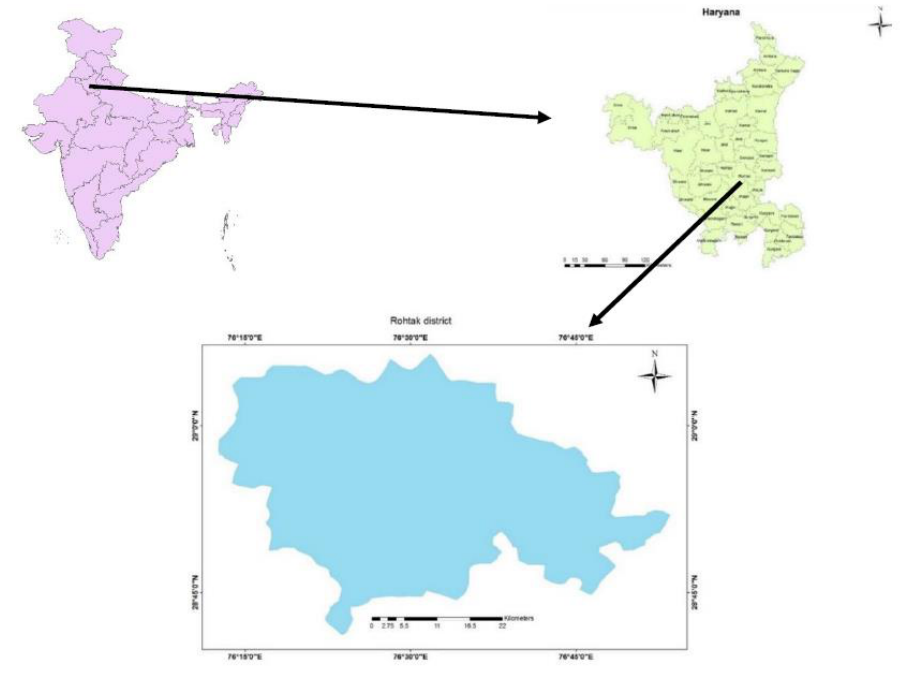
Figure 1. Study Area: Rohtak district, Haryana,